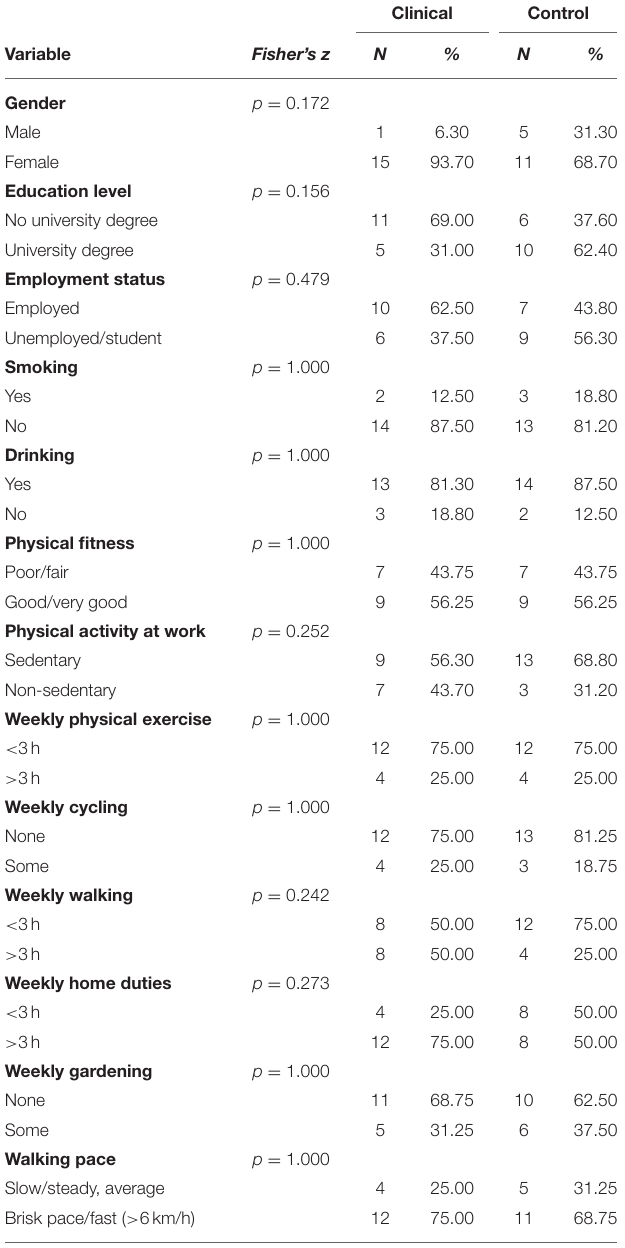
TABLE 1 | Demographic information: categorical